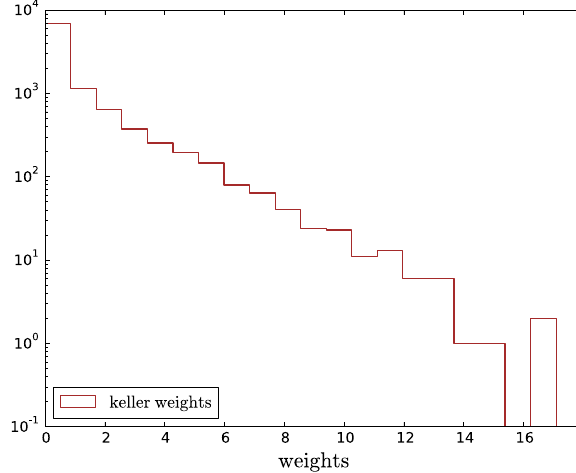
Fig. 24 Weight distribution after reweighting using all LHC pPb data on W / Z